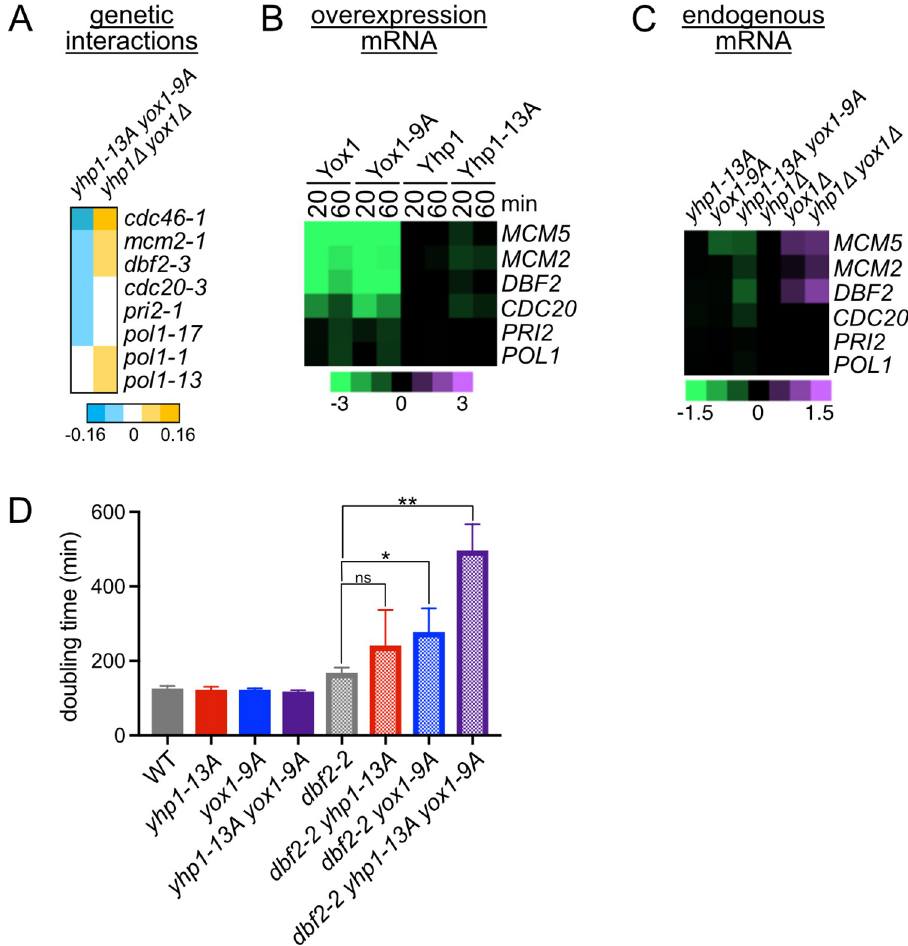
screens described in Fig 1. (B) Gene expression of the indicated Yhp1/Yox1 target genes following acute overexpression of the indicated proteins, from RNAseq experiments in Fig 2. Negative genetic interactions were identified between ts alleles of these genes and yhp1-13A yox1-9A . (C) Expression of genes from (A) in strains expressing the indicated Yhp1/Yox1 mutants from their endogenous promoters, or deleted for the indicated TFs, from RNAseq experiments in S2 Fig. Note the difference in scale between (B) and (C). (D) Doubling times of the indicated strains growing at 30˚C in rich media. Shown is an average of n = 3–5 replicates, error bars indicate standard deviations. Significance was tested using an unpaired t-test, � p < 0.05, �� p < 0.005, ns =